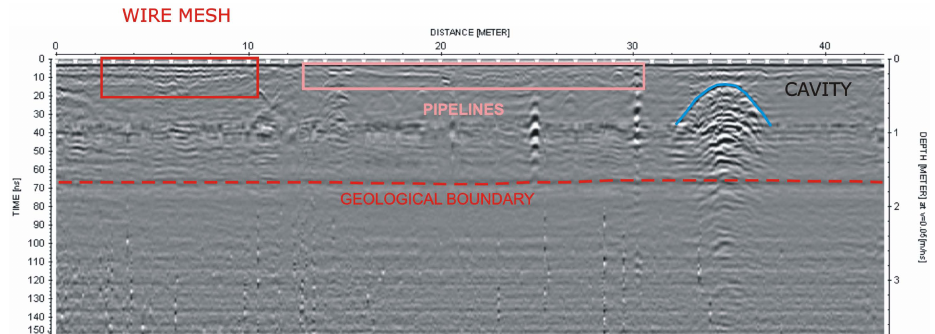
Fig. 6. TS1 GPR carried out along Trieste